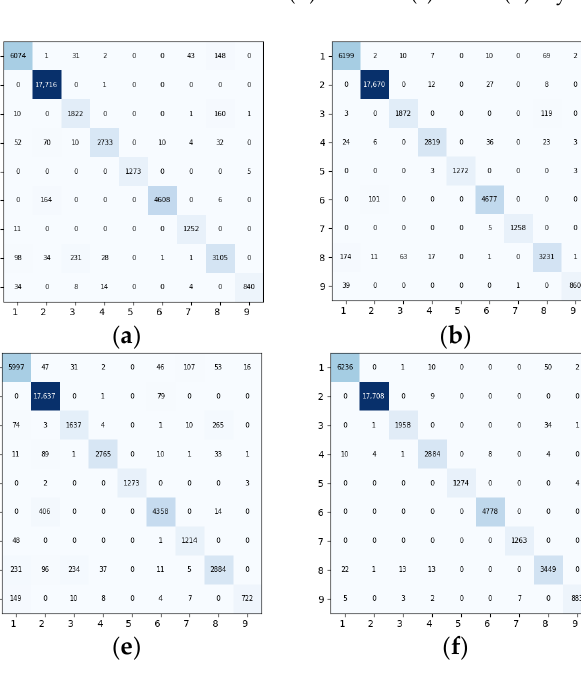
Figure 11. Confusion matrix of different methods for the Indian Pines data set. ( a ) Baseline ( b )